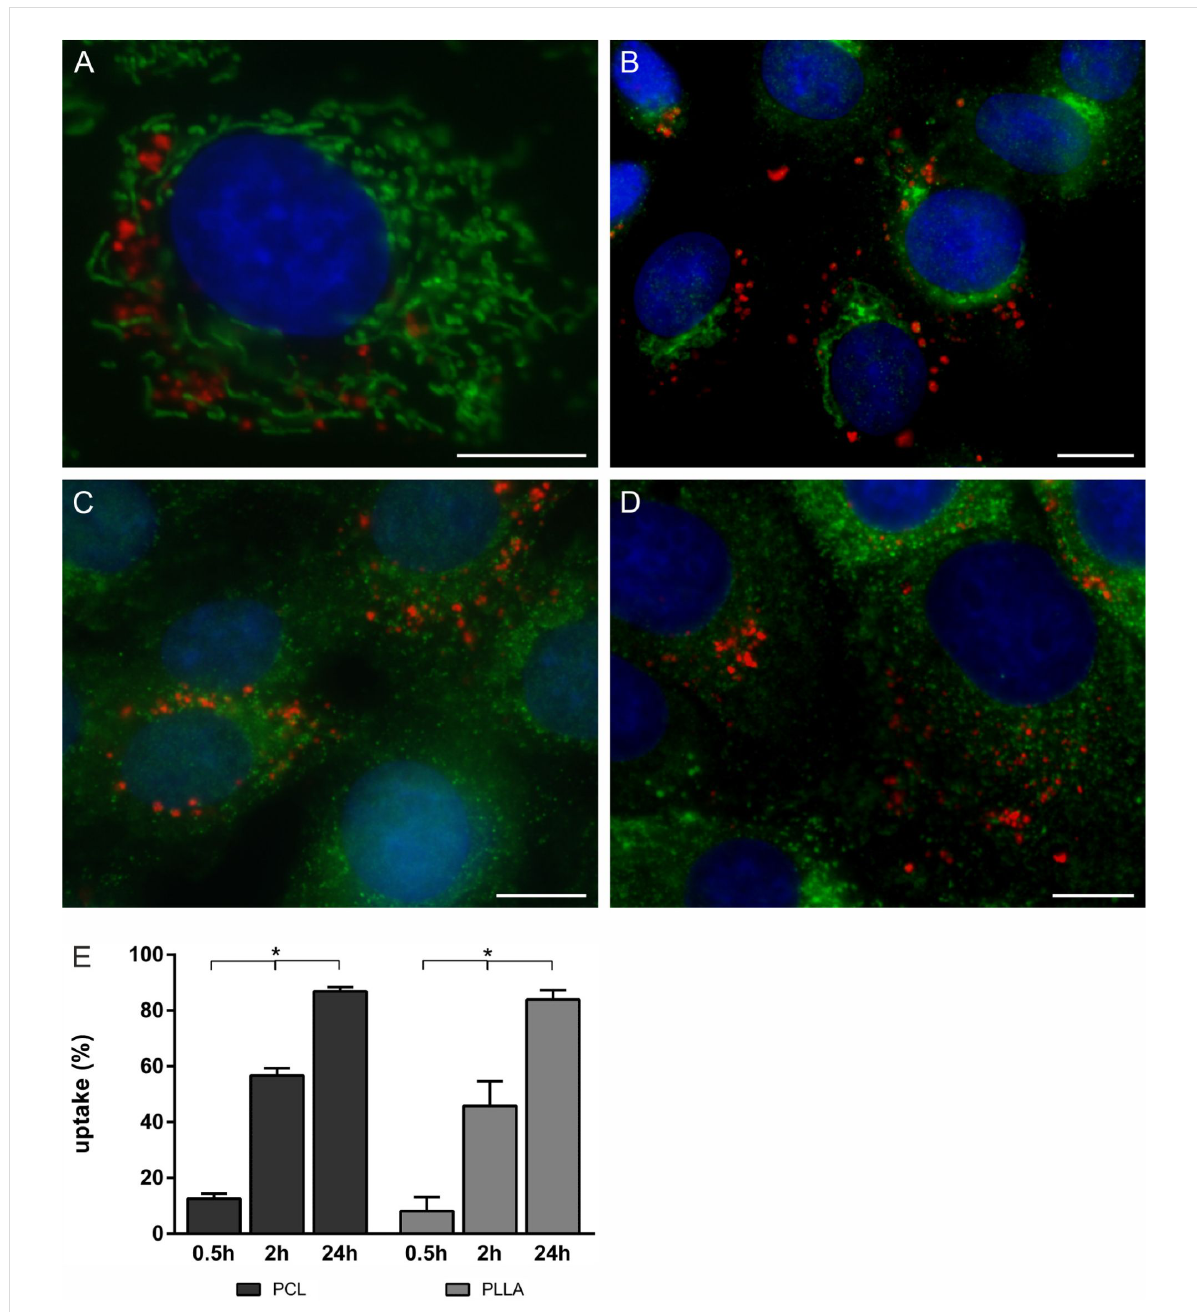
Figure 3: Representative microscopic images of rBCEC4 cells stained for various cell organelles (green) exposed to PCL- (A, B) or PLLA-NPs (C, D) for 24 h. No NPs (red) were found in mitochondria (ATPB-positive organelles) (A), Golgi apparatus (giantin-positive organelles) (B), lysosomes (LAMP1-positive organelles) (C) or in the ER (calreticulin-positive organelles) (D). Cell nuclei were counterstained with Hoechst (blue). Scale bars 10 µm. Uptake of PCL- and PLLA-NPs into rBCEC4 cells after 0.5, 2 or 24 h of NP exposure was quantified using high-content analysis (E). Both PCL- and PLLA-NPs showed a similar and time-dependent uptake pattern. Concentrations of PCL- or PLLA-NPs were [24.9 µg/mL]. Error bars repre- sent SEM. Significant differences between exposure times are labeled with asterisks (*) (* = p ≤ 0.0001).